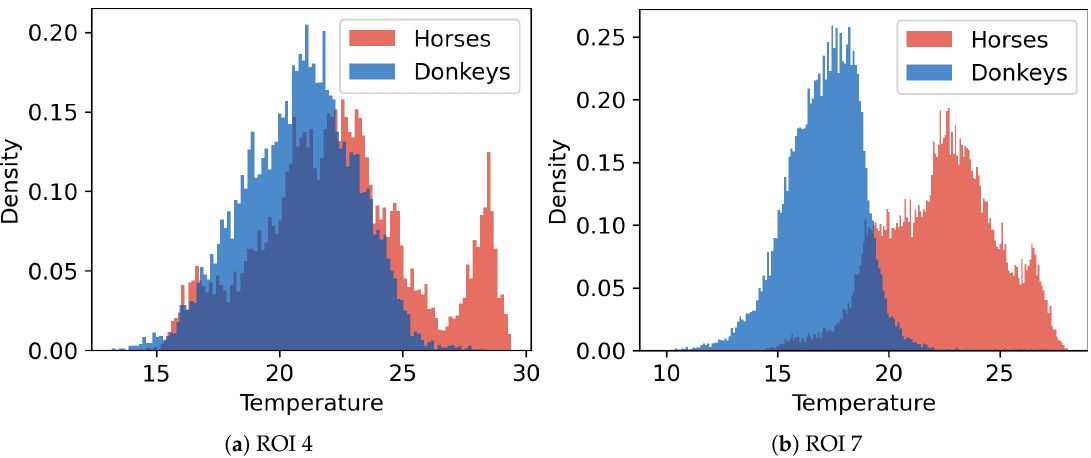
Figure 4. Visualization of temperatures in ROIs (ordered by their medians) of all animals: ( a ) horses; ( b ) donkeys.